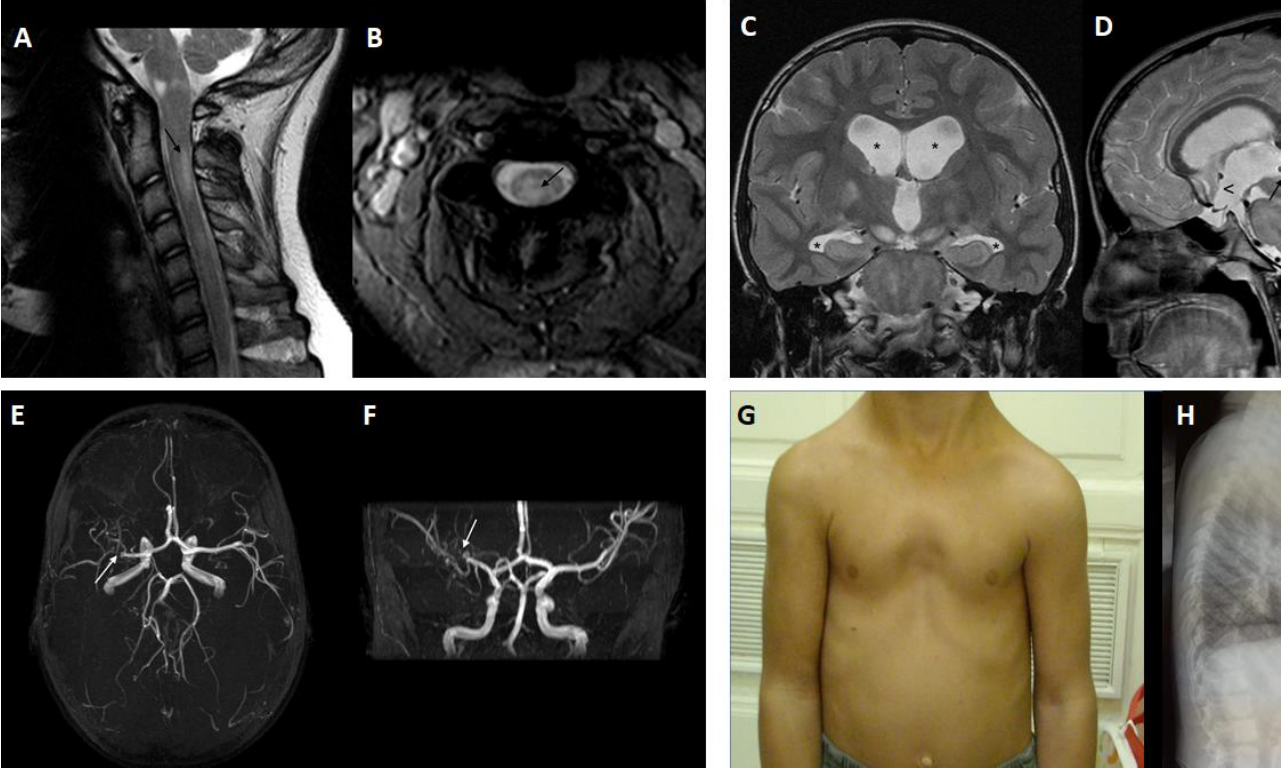
Figure 4. Sagittal ( A ) and axial bFFE STIR-FSE ( B ) MR images of the cervical spine showing at C2-C3 level a focal area of hyperintensity located on the right posterior side of the medulla, compatible with UBO. T2-weighted coronal sequence showing dilation of the frontal and temporal horns of the lateral ventricles (asterisk) ( C ). T2-weighted sagittal MR image ( D ) showing aqueduct stenosis (black arrow) with widening of the hypothalamic recess. Angio-MR image in a boy with Moyamoya vasculopathy ( E , F ): the 3D time-of-flight technique with sagittal and coronal maximum intensity projection reconstructions shows focal stenosis of the M1 segment of the right middle cerebral artery (white arrow); “Moyamoya-type” collateral vessels are visible. Sternum excavatum ( G ) and profile X-ray showing malformation of the sternum ( H ).